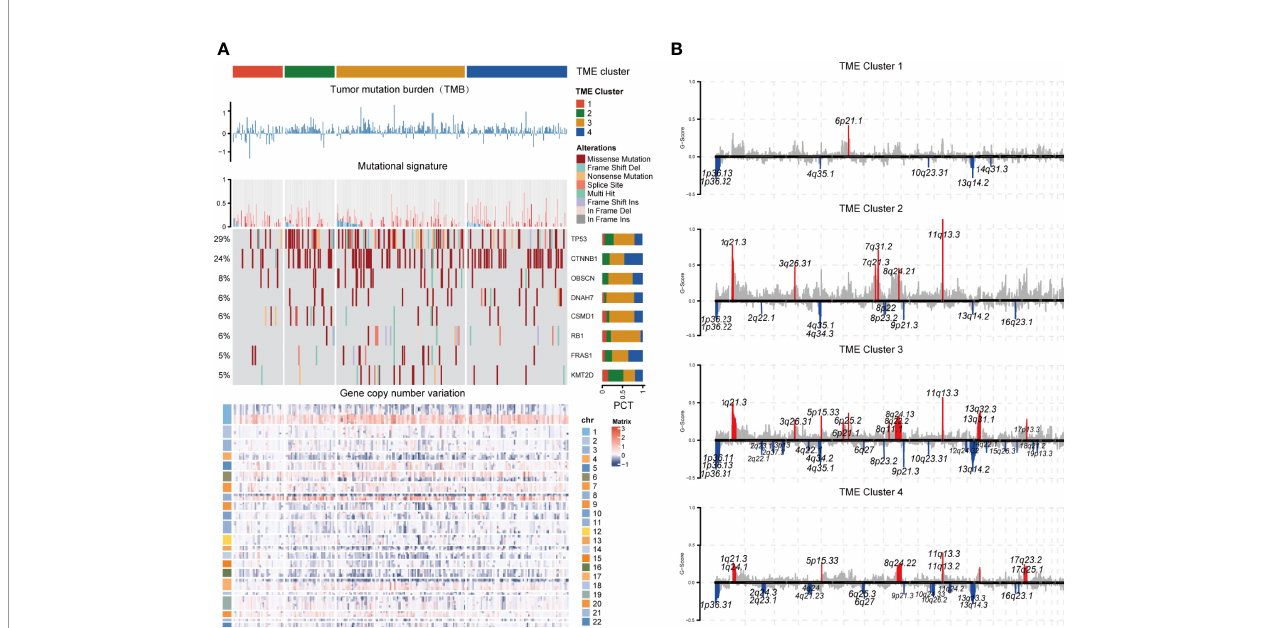
FIGURE 5 | Genomic alteration landscape of each TME cluster. (A) The log10TMB of each cluster, gene-level CNV mutational signature, waterfall chart of signi fi cant (>5%) and differently (Fisher ’ s exact test p < 0.1) mutated genes, and heatmap of gene copy number variation were shown from the top to the bottom panels. Patients were ordered by the combined contribution of APOBEC-related mutational signatures (SBS2 + SBS13) with each cluster. (B) GISTIC copy number variation analysis. The ampli fi cations and deletions of chromosomal regions were colored red and blue, respectively (FDR cutoff: 0.01).